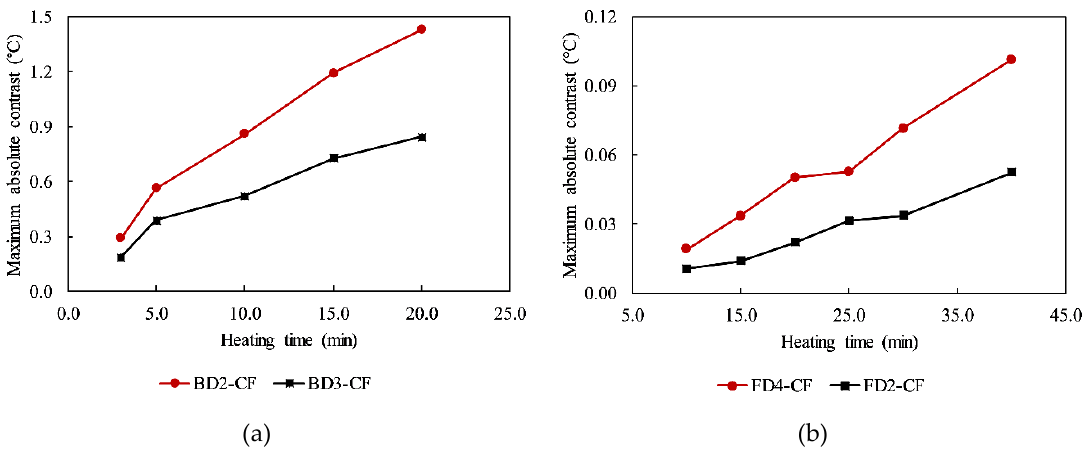
Figure 7. Maximum absolute contrast values of delaminations: ( a ) BD2-CF and BD3-CF; ( b ) FD4-CF and FD2-CF.